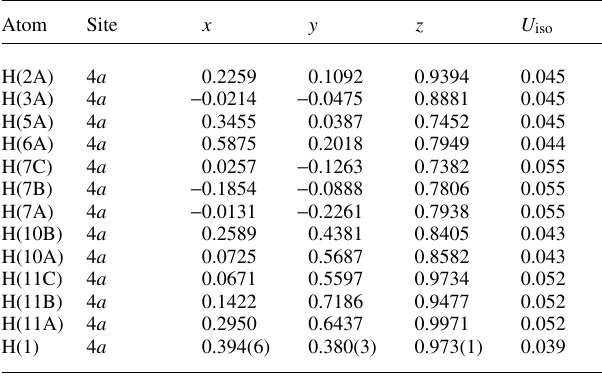
Table 2. Atomic coordinates and displacement parameters (in Å 2 )